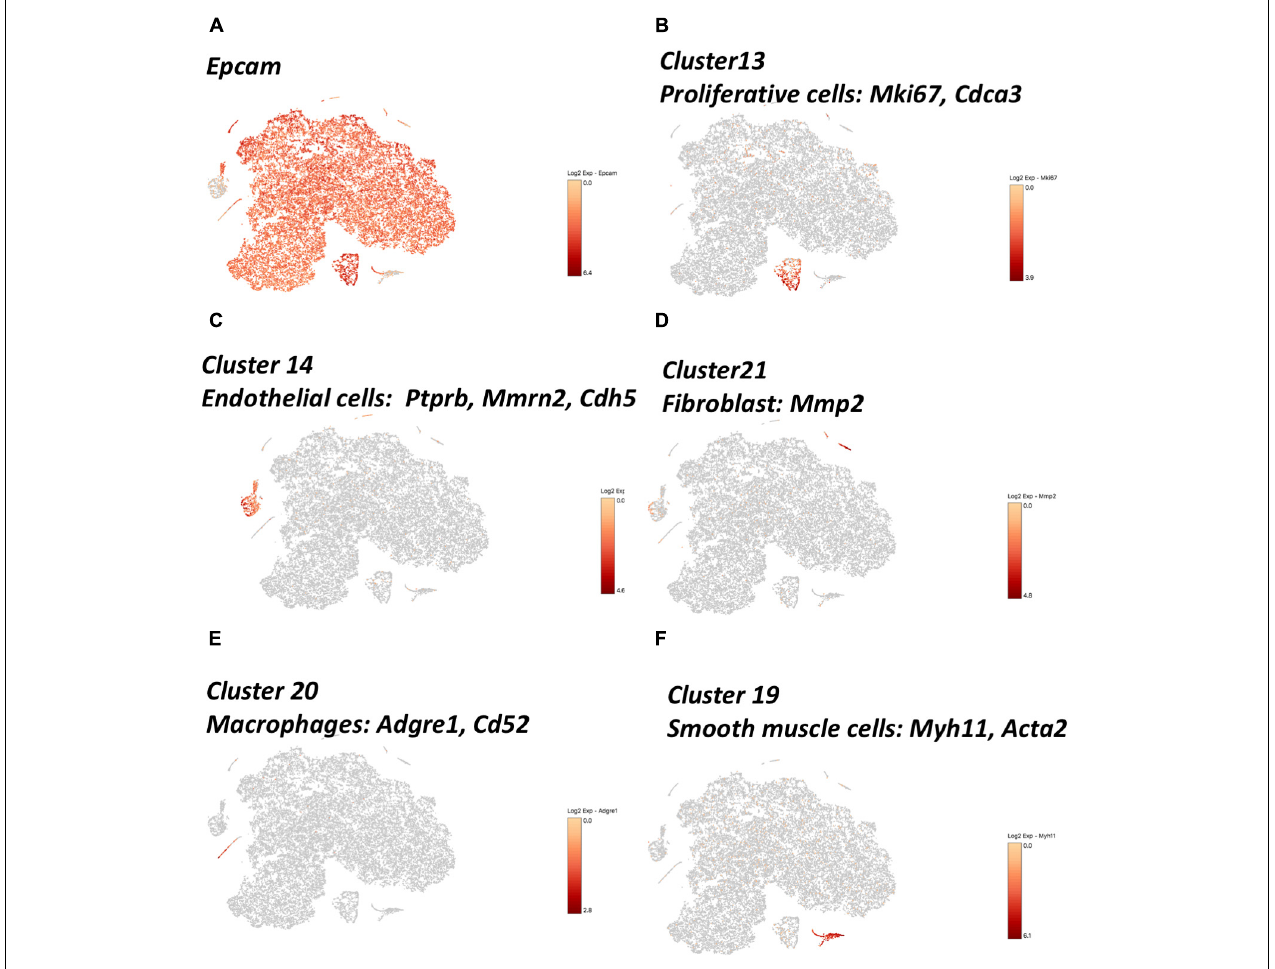
FIGURE 2 | t-SNE plot showing the expression of known marker genes indicating cell types. (A) epithelial cells, Epcam ; (B) proliferating cells, Mki67 , Cdca3 ; (C) endothelial cells (ECs), Ptprb , Mmrn2 , Cdh5 ; (D) fibroblast (FBs), Mmp2 ; (E) macrophages, Adgre1 , Cd52 ; (F) smooth muscle cells, Myh11 ,